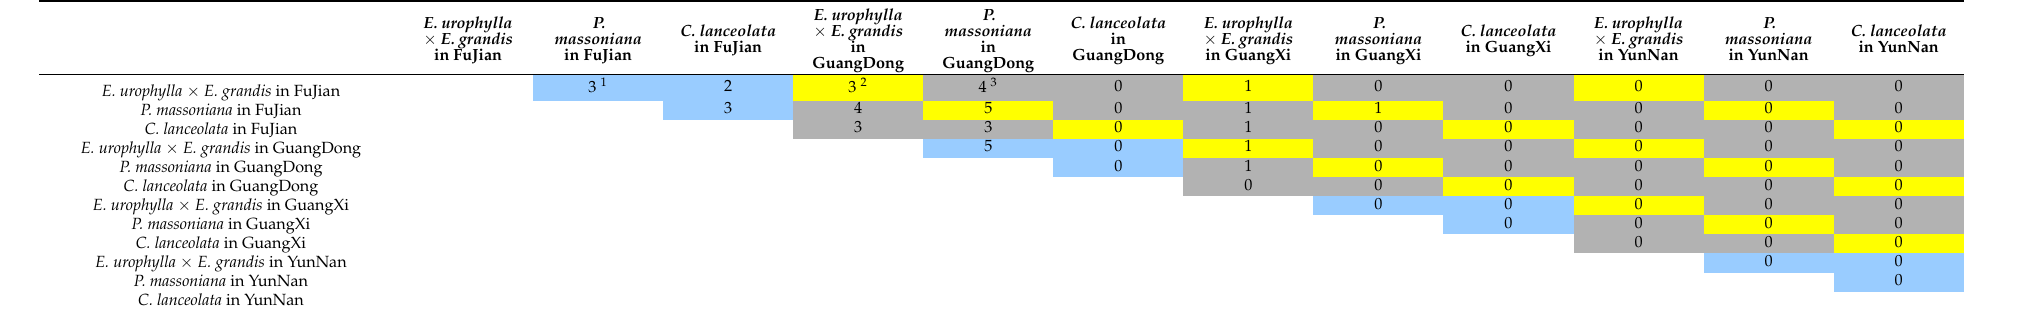
Table A5. Number of shared genotypes of Calonectria hongkongensis determined by tef1 and tub2 gene sequences between different plantation tree species ×